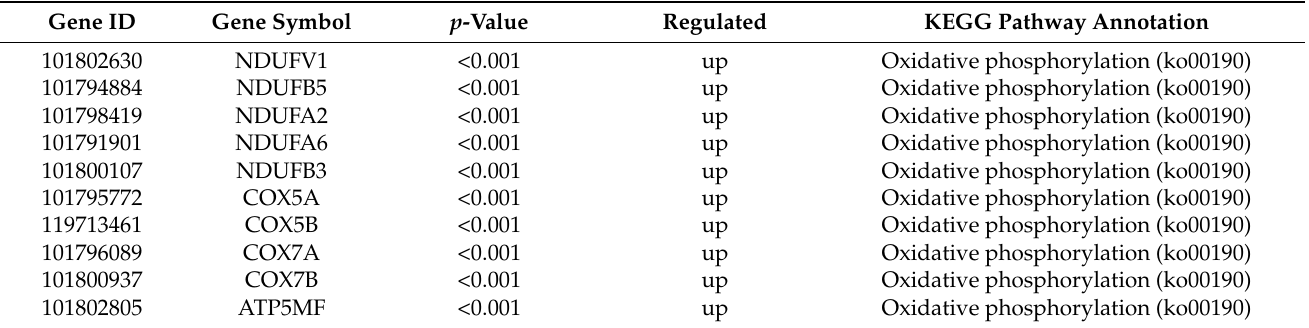
Table 5. The top 10 DEGs with known functions contained in oxidative phosphorylation